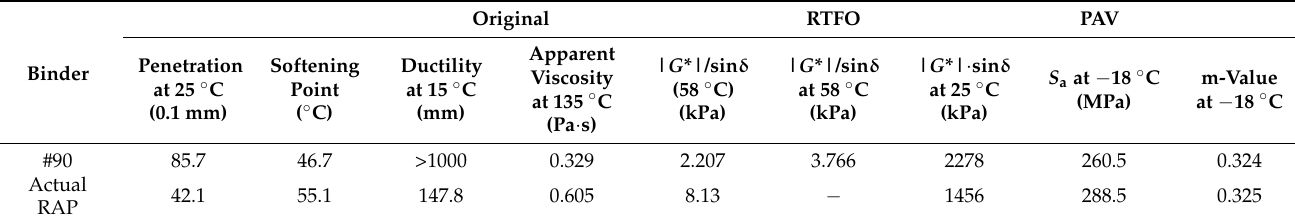
Table 1. Properties of the #90 and actual RAP binders.